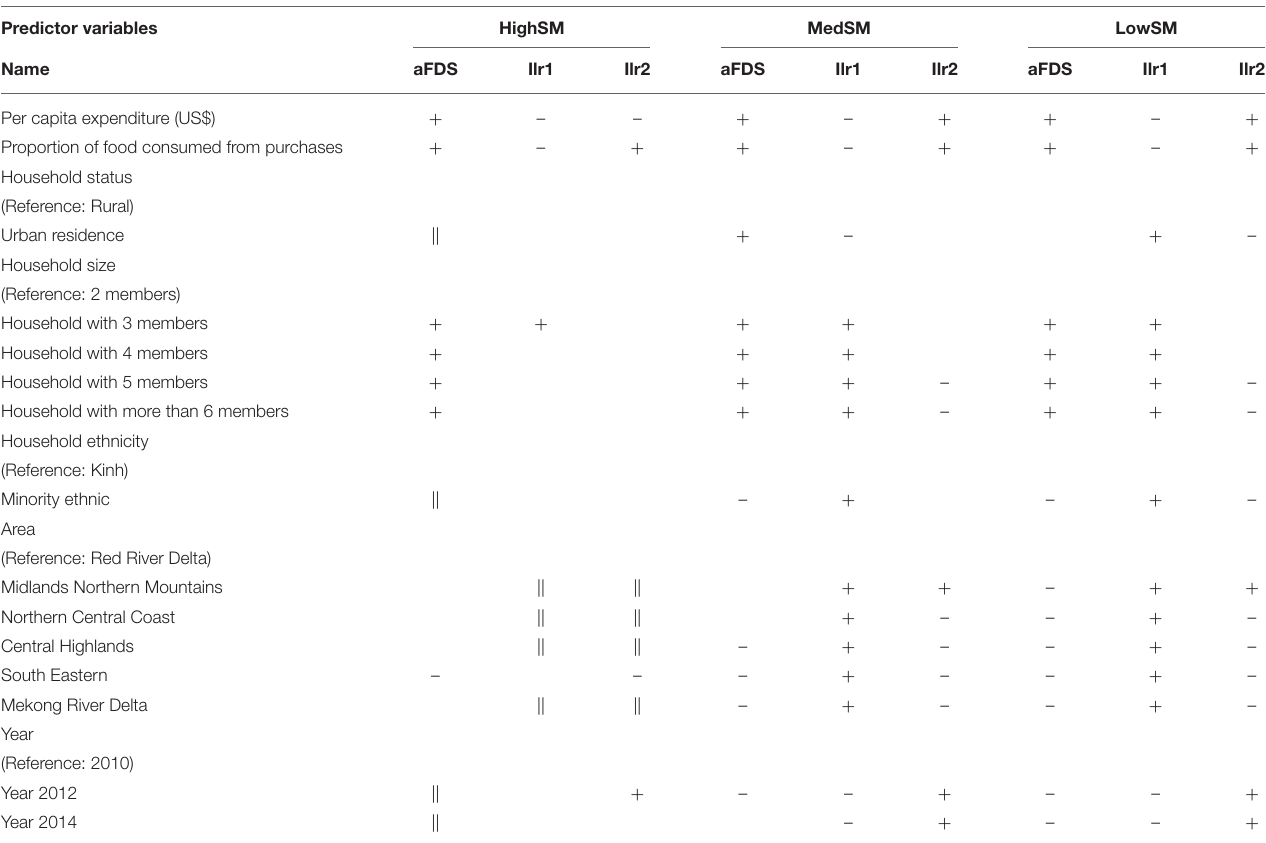
TABLE 4 | Summary of estimation results: directions of significant impacts. Predictor